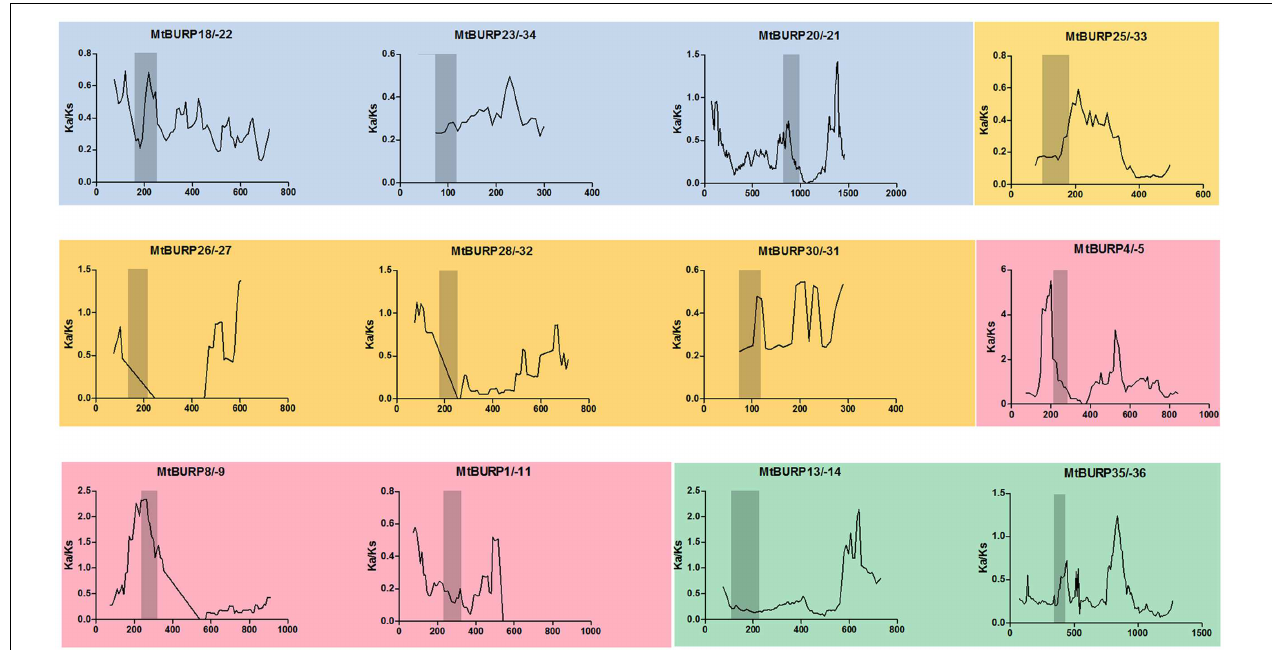
FIGURE 4 | Sliding window analysis employed to estimate selective pressures on paralogous BURP gene pairs in Medicago . Four different colors reprent that paralogous BURP gene pairs came from different subfamilyes. As shown in the key, the gray blocks, indicate the positions of the BURP domain. The window size is 150 bp, and the step size is 9